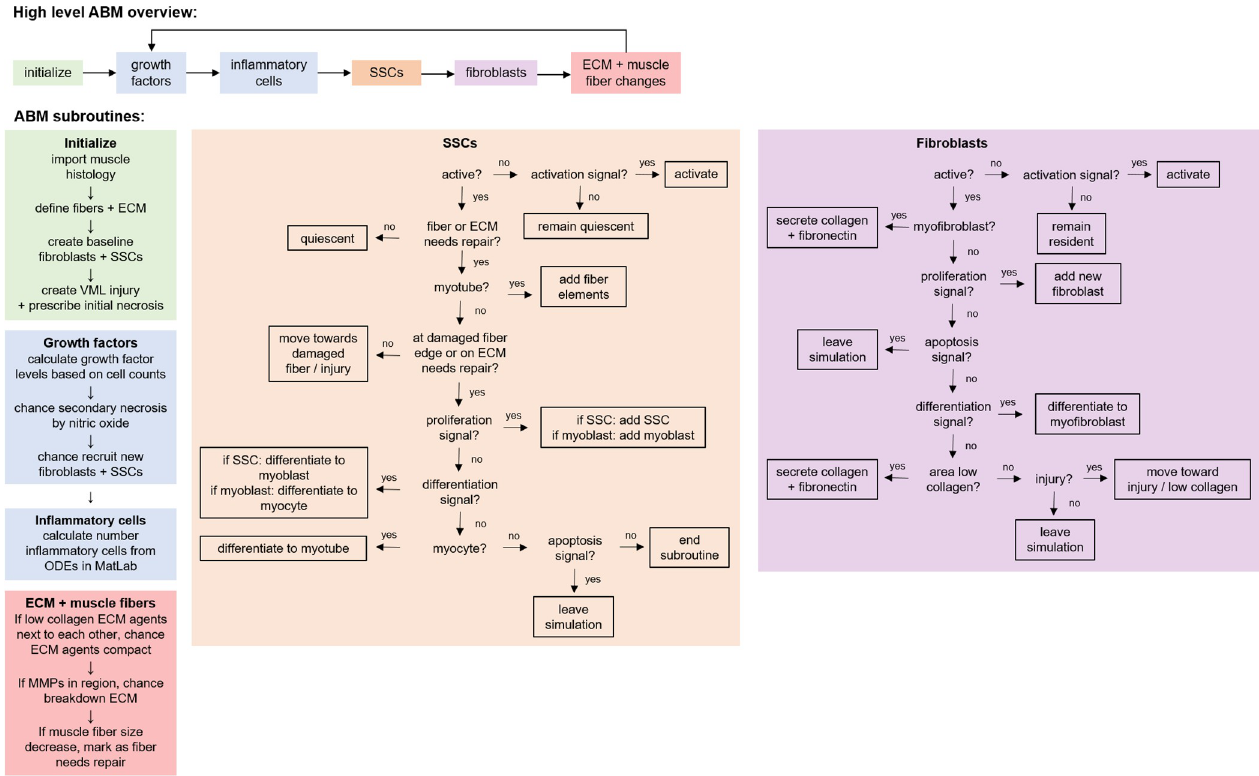
Fig 3. Flowchart depicts the ABM rules, logic flow, and agent actions. After initialization, the growth factors and inflammatory cells are calculated during each subsequent time step. Then SSCs, fibroblasts, fibers, and ECM follow a probability-based decision tree to guide their actions.